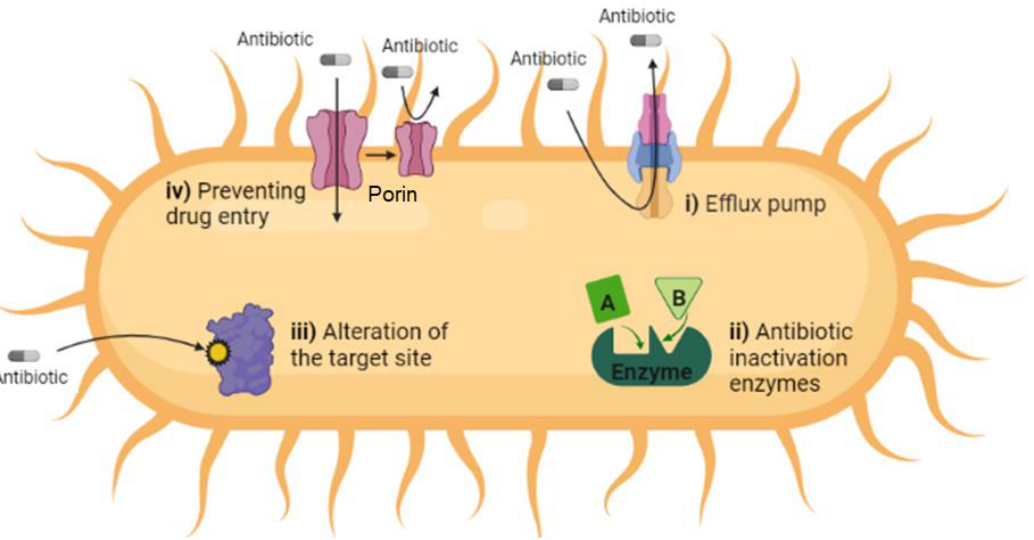
Figure 2. Schematic diagram highlighting the main antimicrobial resistance mechanisms in pathogenic bacteria, which include: (i) drug efflux systems, which expel the antimicrobials outside the bacterial cell and reduce their effectiveness to non-toxic levels. (ii) Antibiotic inactivation enzymes, which modify or destroy the structure of antibiotics. (iii) Alteration of the target site, which usually occurs in the cell envelope via spontaneous mutation via chemical modification of their molecular targets. (iv) Preventing drug entry by modifying the frequency, size and selectivity of porin channels, which are found in the bacterial envelope and play a crucial role in antibiotic entry into the bacterial cell.